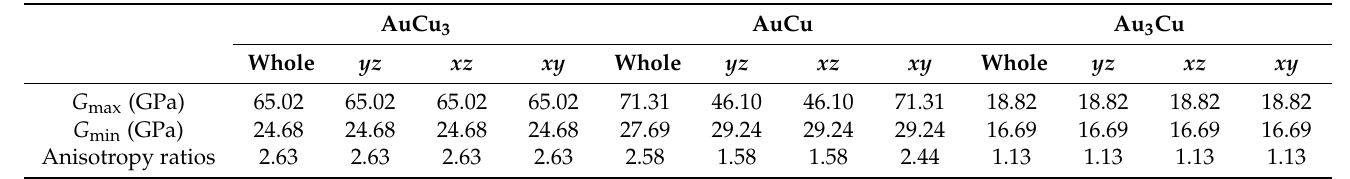
Table 6. Anisotropy ratios and maximum and minimum share moduli G for AuCu 3 , AuCu, and Au 3